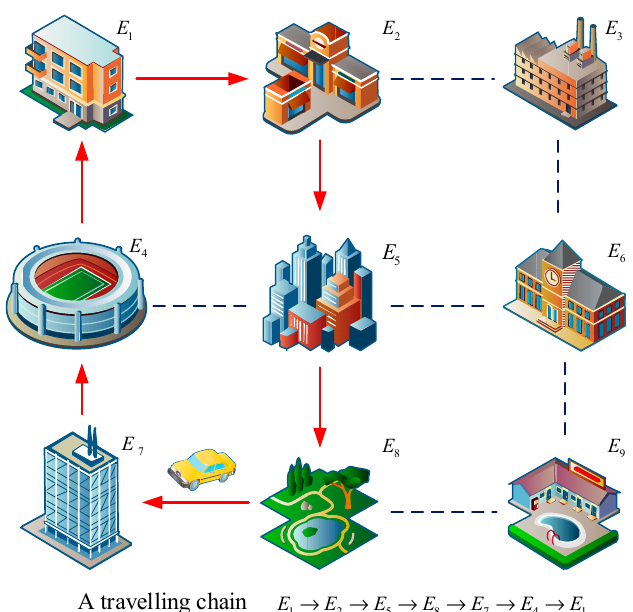
Figure 2. The travelling chain of a typical day.